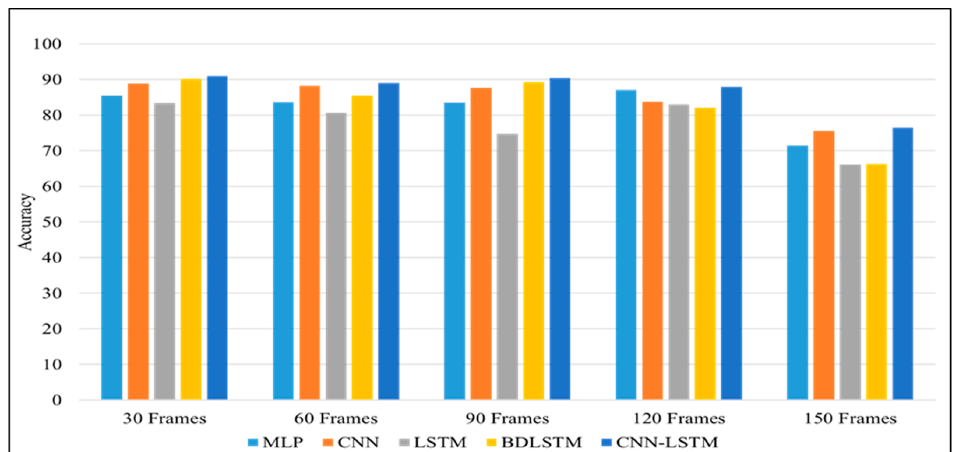
Figure 7. Confusion of CNN-LSTM on different frames sequences.